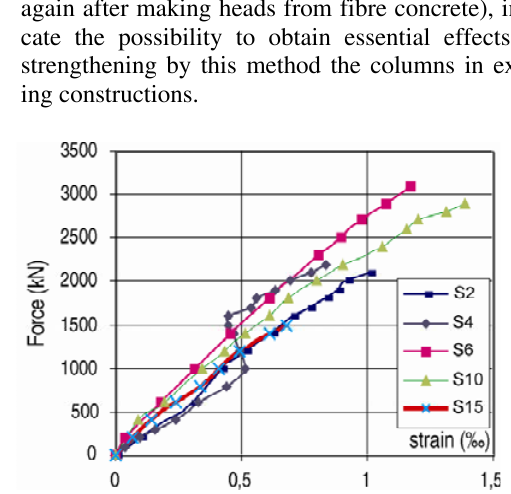
Fig 12 . Strains of concrete core in different testing types of composite columns